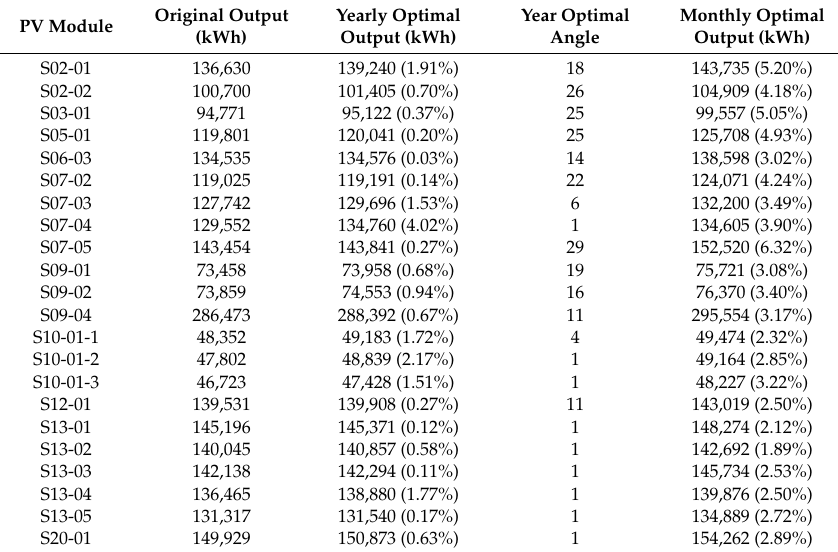
Table 7. Simulation Result of 2017 PV modules.